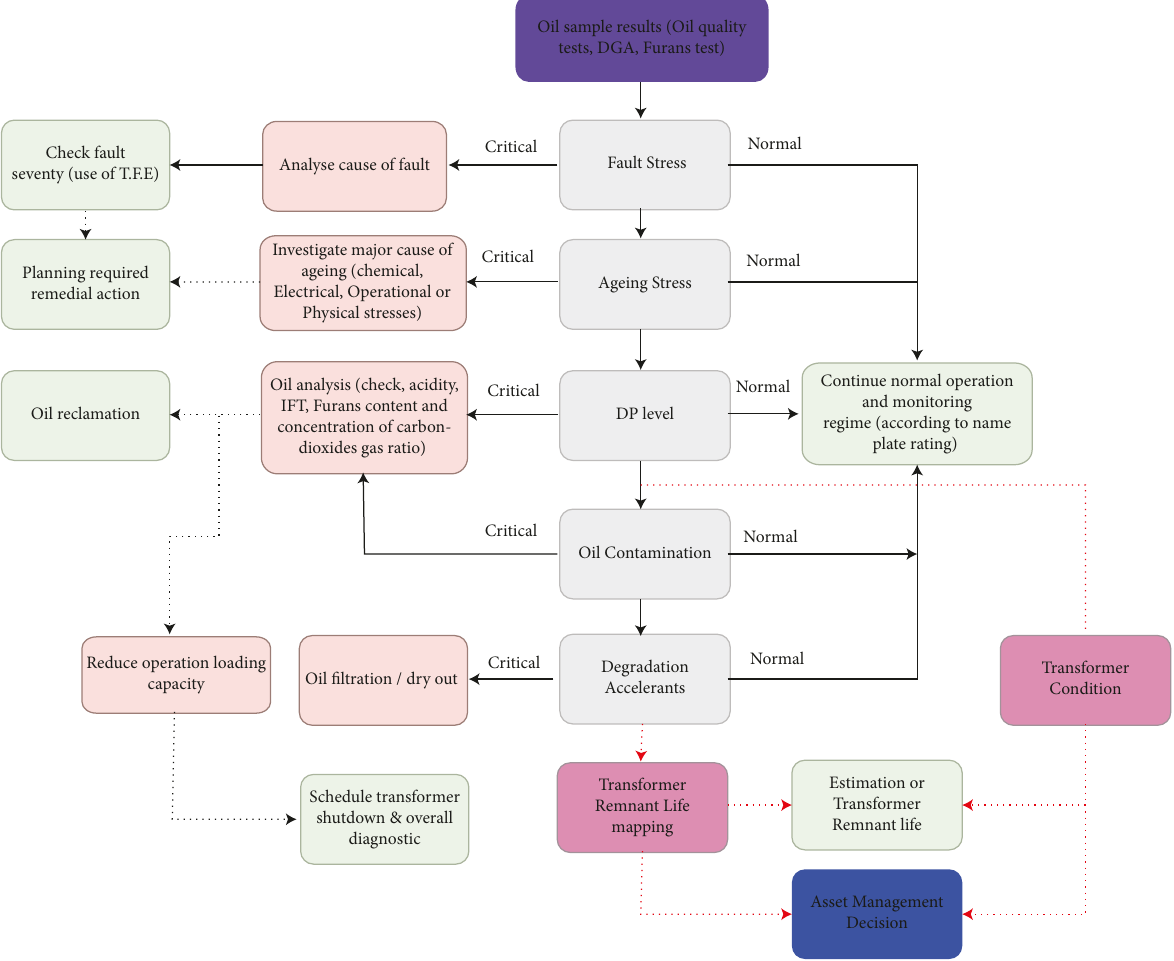
Figure 8: Block for remnant life and management decision